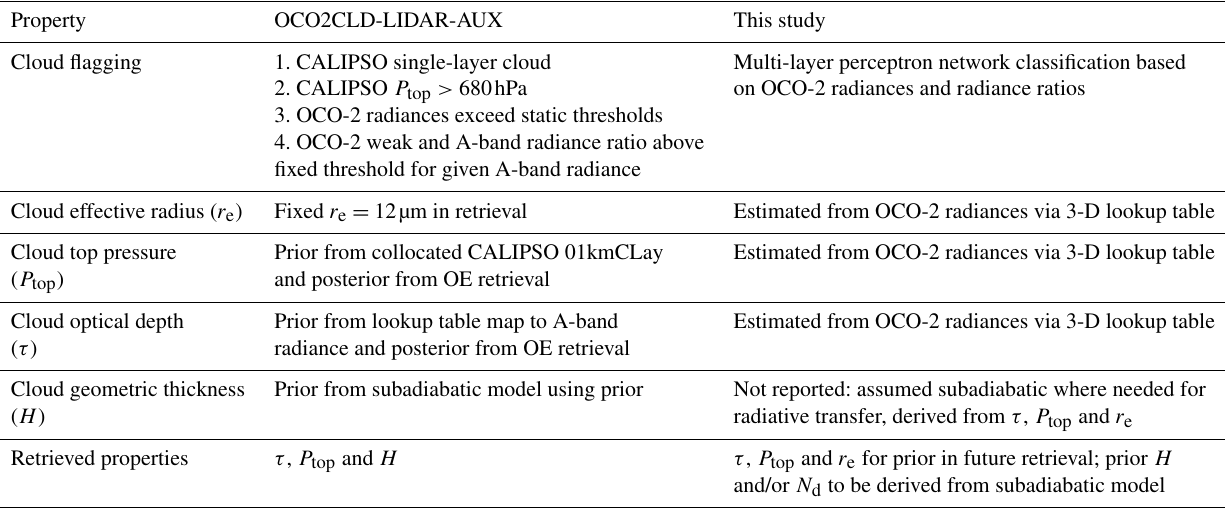
Table 1. Summary of methods for determining properties in OCO2CLD-LIDAR-AUX and changes introduced in this study. OCO2CLD- LIDAR-AUX is a full optimal-estimation (OE) retrieval that combined CALIPSO and OCO-2 information to obtain its prior state. This study is intended to provide OCO-2-only prior information for a future OE retrieval.